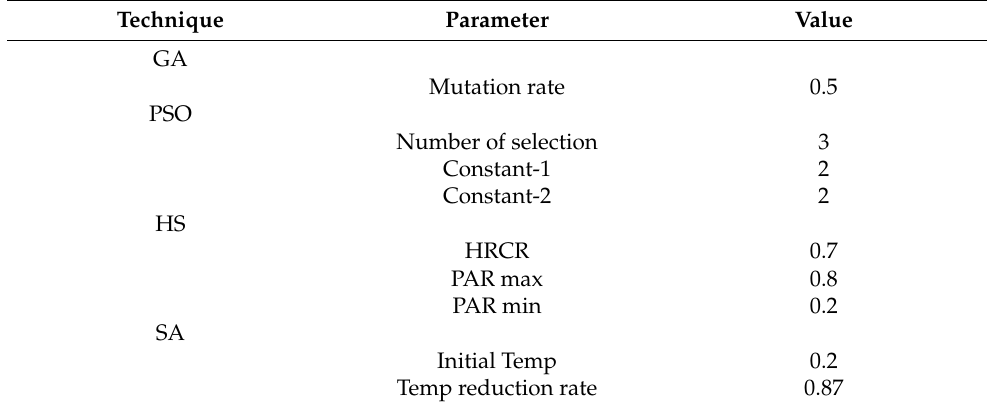
Table 5. Feature selection parameters